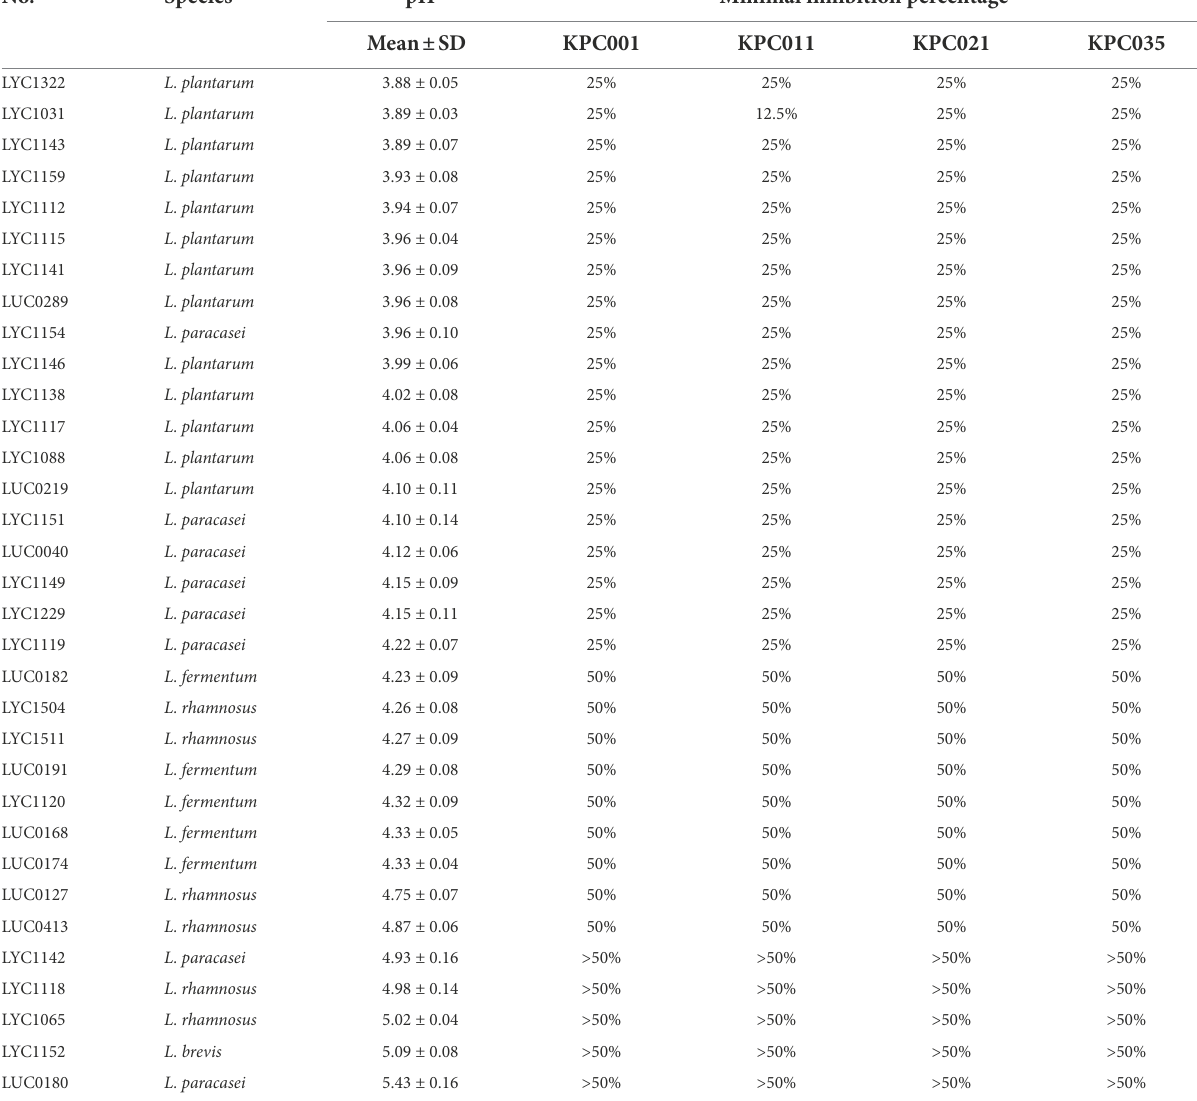
TABLE 1 The resulting pH and MIPs of Lactobacillus strain cell-free supernatants (%) against KPC-2-producing Klebsiella pneumoniae.